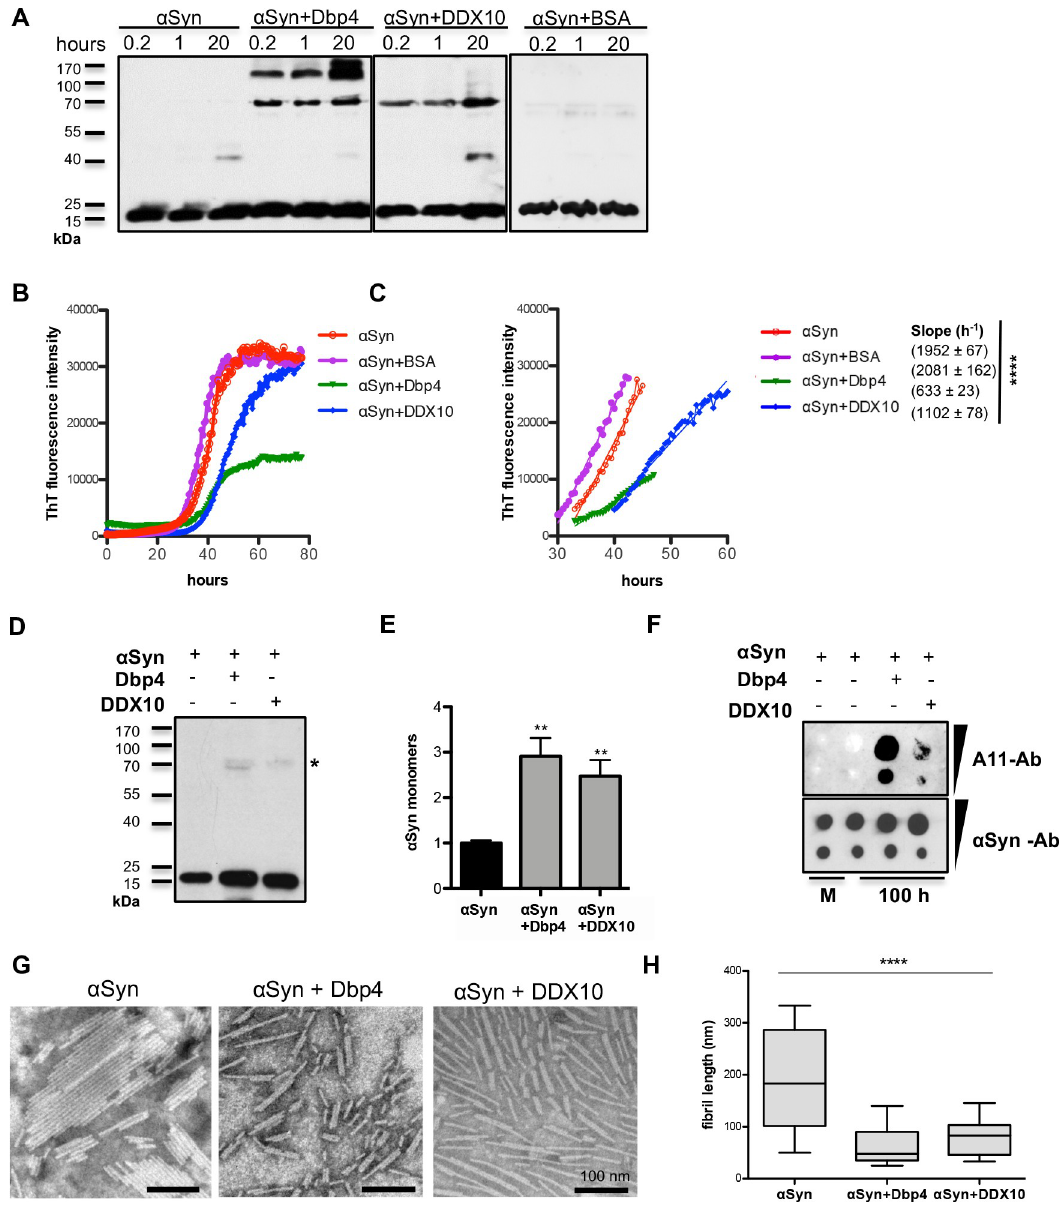
Fig 8. Dbp4 and DDX10 induce oligomerization and reduce the fibrilization of α Syn. (A) Immunoblotting of purified α Syn incubated either alone or with Dbp4, DDX10 or BSA purified proteins at molar ratio 2:1 (C α Syn = 10 μ M) using α Syn antibody. Equal aliquots were taken after 10 min, 1 h and 20 h. (B) Aggregation kinetics of α Syn in the presence or absence of Dbp4, DDX10 or BSA as a control, monitored by ThT fluorescence emission. The ThT signal was recorded every 2 minutes for 80 h. Representative curves from three independent experiments are presented. ( C) Slope of the curves in exponential phase. Significance of differences was calculated with One-way ANOVA ( ���� p < 0.0001). (D) Immunoblotting of equal amounts of samples from end point products from (B) using α Syn antibody. (E) Quantification of the band density representing the amount of monomeric α Syn of samples from (D). The signal intensity was normalized to α Syn alone (n = 3). (F) Dot-blot analysis of samples from end point products from (B). 10 μ l and 2 μ l from each sample were applied on a membrane and probed with A11 anti-oligomer antibody. The membrane was stripped and probed with α Syn antibody that recognizes all protein species as a control for adsorbed protein onto the membrane. M: monomeric α Syn. (G) TEM images obtained with end point products of the kinetic run (B) reveal formation of mature amyloid fibrils. (H) Measurements of the mean length of α Syn fibrils in absence or presence of Dbp4 or DDX10. Significance of differences was calculated with One-way ANOVA ( ���� p < 0,0001, n =